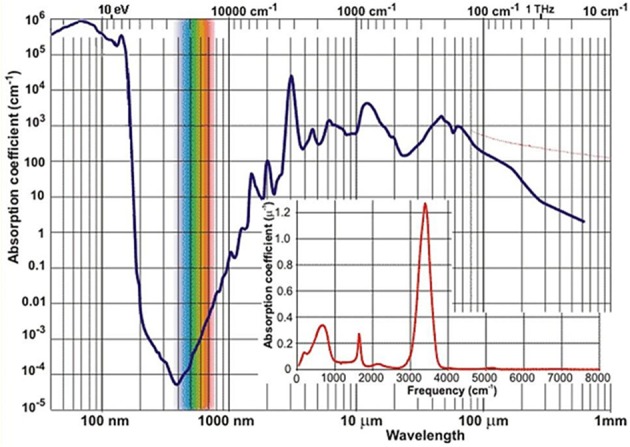
The spectrum of absorption coefficient of liquid water2.